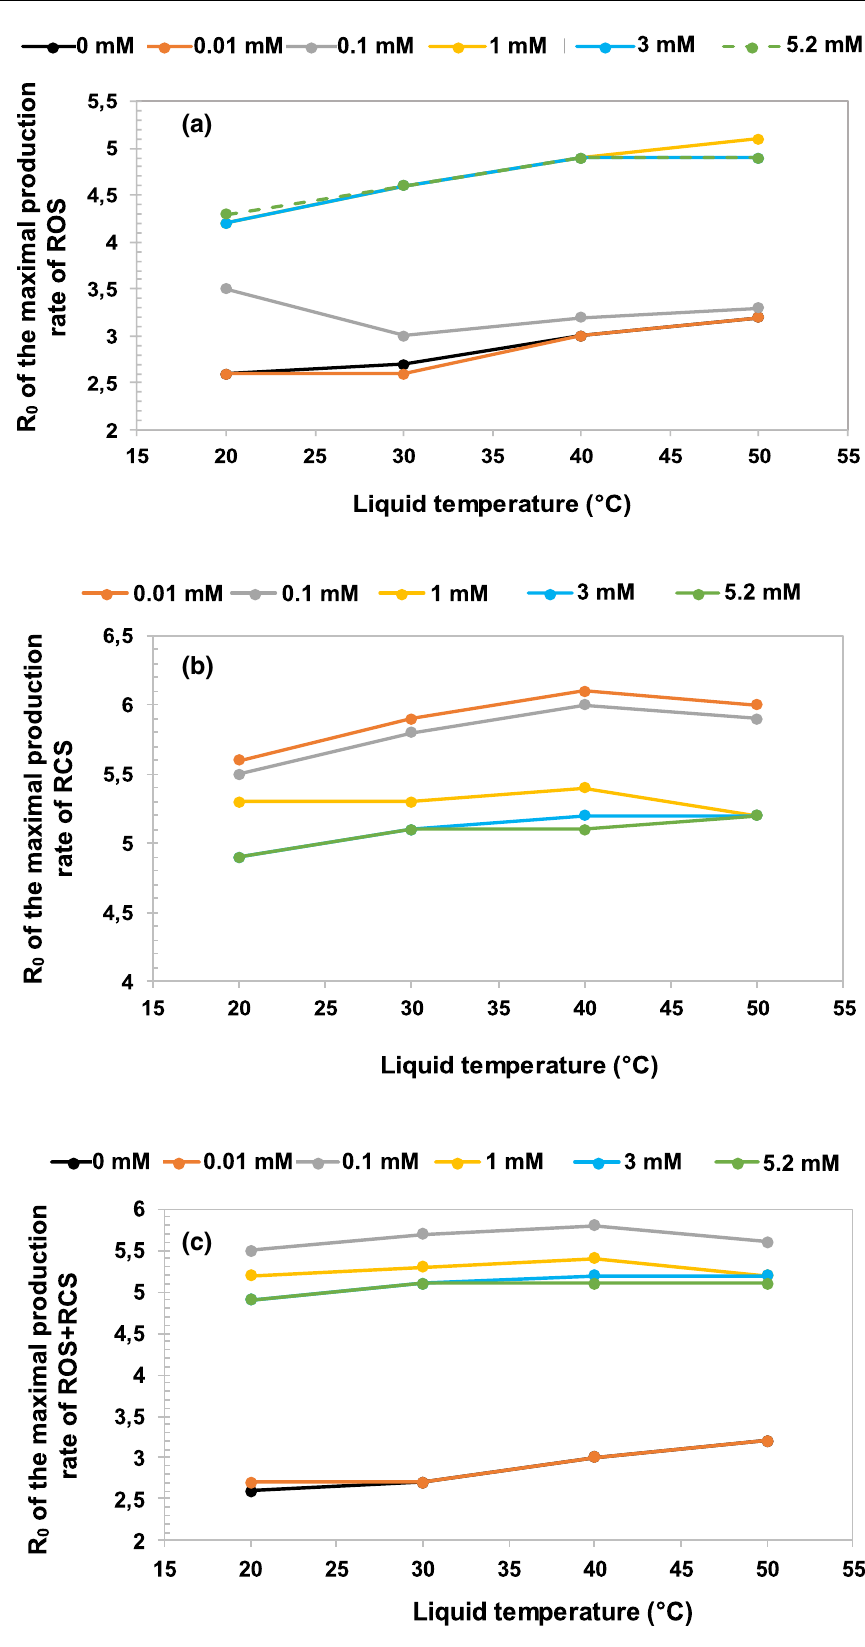
Fig. 2 Optimum ambient bub- ble radii (R 0 ) for the maximal production rate of a ROS ( •